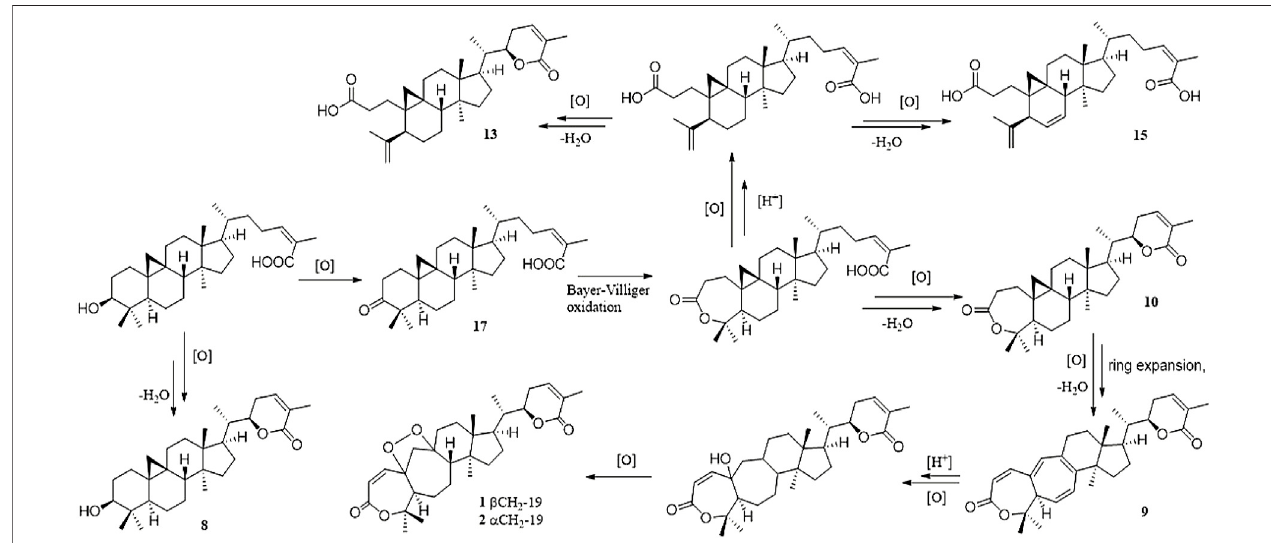
FIGURE 5 | Plausible biosynthetic pathway for 1, 2, 8 – 10, 13, 15 , and 17 .